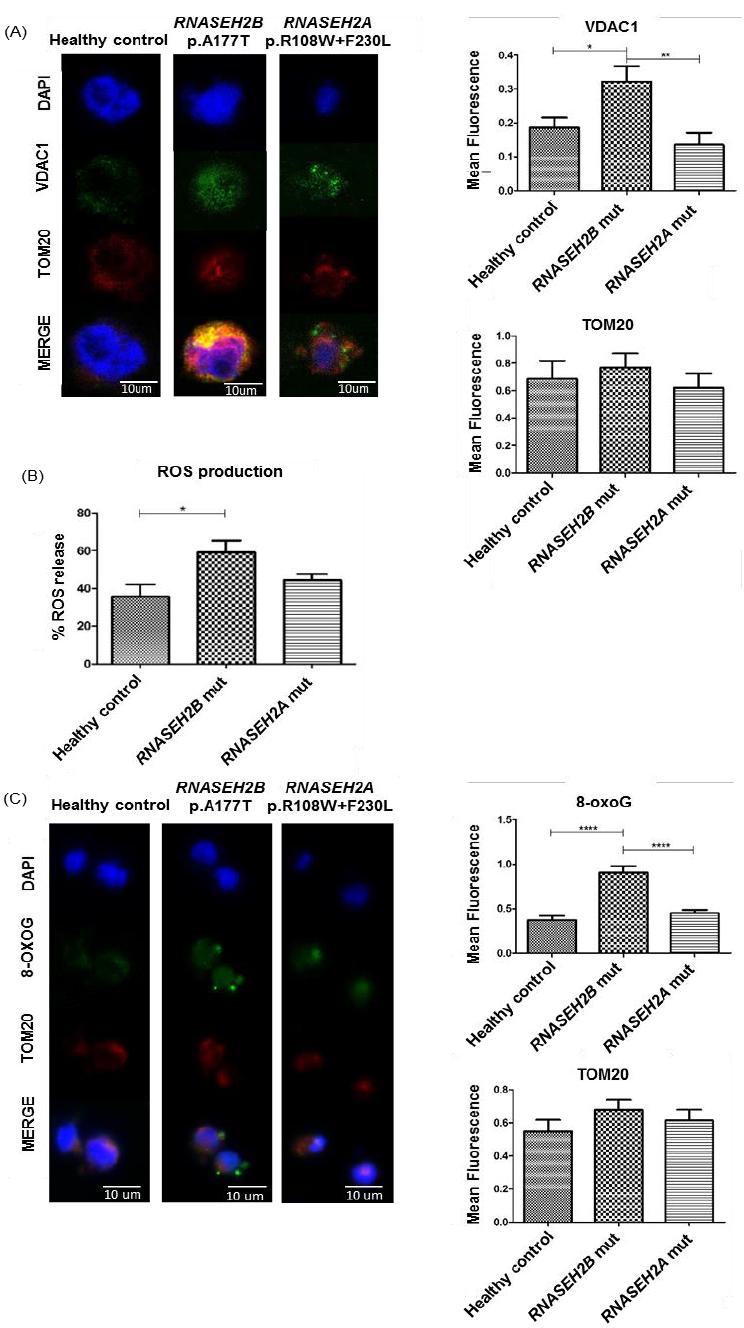
Figure 2. Mitochondrial stress in RNASEH2-mutated LCLs and healthy control. ( A ) Immunofluores- cence and mean fluorescence (representative confocal images-Leica DM IRBE, Leica Microsystems Srl, Buccinasco, Italy) of LCLs derived from a healthy control and AGS patients mutated in RNASEH2B and RNASEH2A genes stained with VDAC1 antibody (green), TOM20 (red) and DAPI for nuclear staining (blue). ANOVA test and post hoc analysis Tukey ’ s Test have been performed. * p < 0.05, ** p < 0.01. ( B ) Flow cytometry analysis of ROS production in AGS patients mutated in RNASEH2B and RNASEH2A genes. The bar graph represents the mean of three biological experi- ments. ANOVA test and post hoc analysis Tukey ’ s Test have been performed. * p < 0.05. ( C ) Immu- nofluorescence and mean fluorescence of LCLs derived from a healthy control and AGS patients mutated in RNASEH2B and RNASEH2A genes stained with 8-oxoG antibody (green), TOM20 (red) and DAPI for nuclear staining (blue). ANOVA test and post hoc analysis Tukey ’ s Test have been performed. **** p < 0.0001.